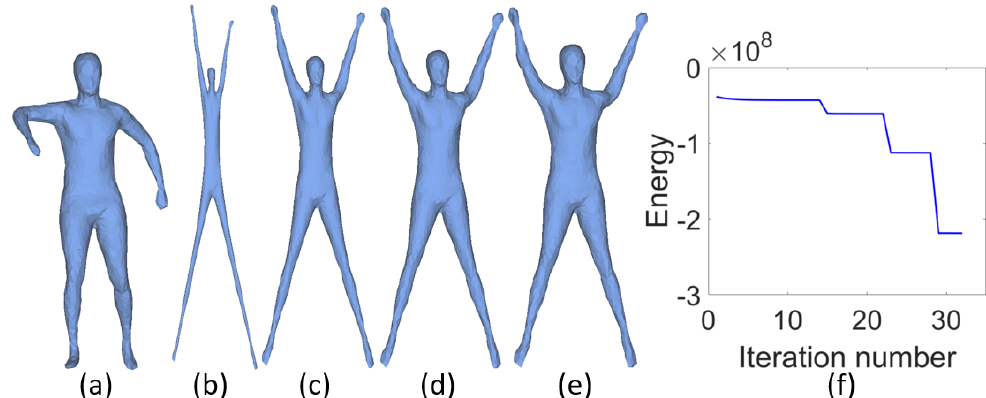
Figure 3. From left to right are the original tetrahedral mesh ( a ), the result of the first cascade ( b ), the result of the second cascade ( c ), the result of the fourth cascade ( d ), the result of the fourth cascade ( e ), and the convergence curve of the objective function ( f ). The jumps in ( f ) are caused by the incremental increasing of β .